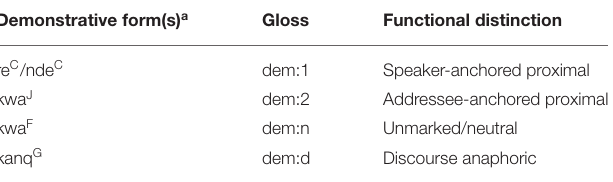
TABLE 1 | The Quiahije Chatino demonstrative